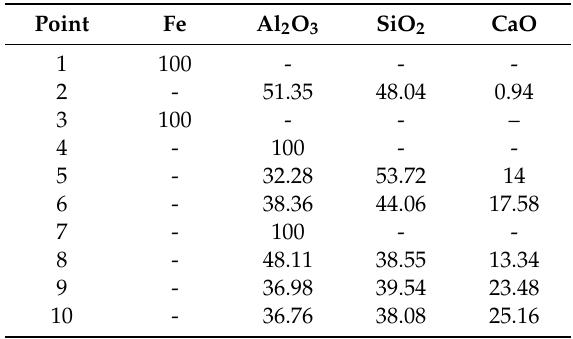
Figure 14. Microstructures of the slags obtained from smelting separation at different basicity levels. Table 8. The EDS analysis of Figure 14 (wt. %).